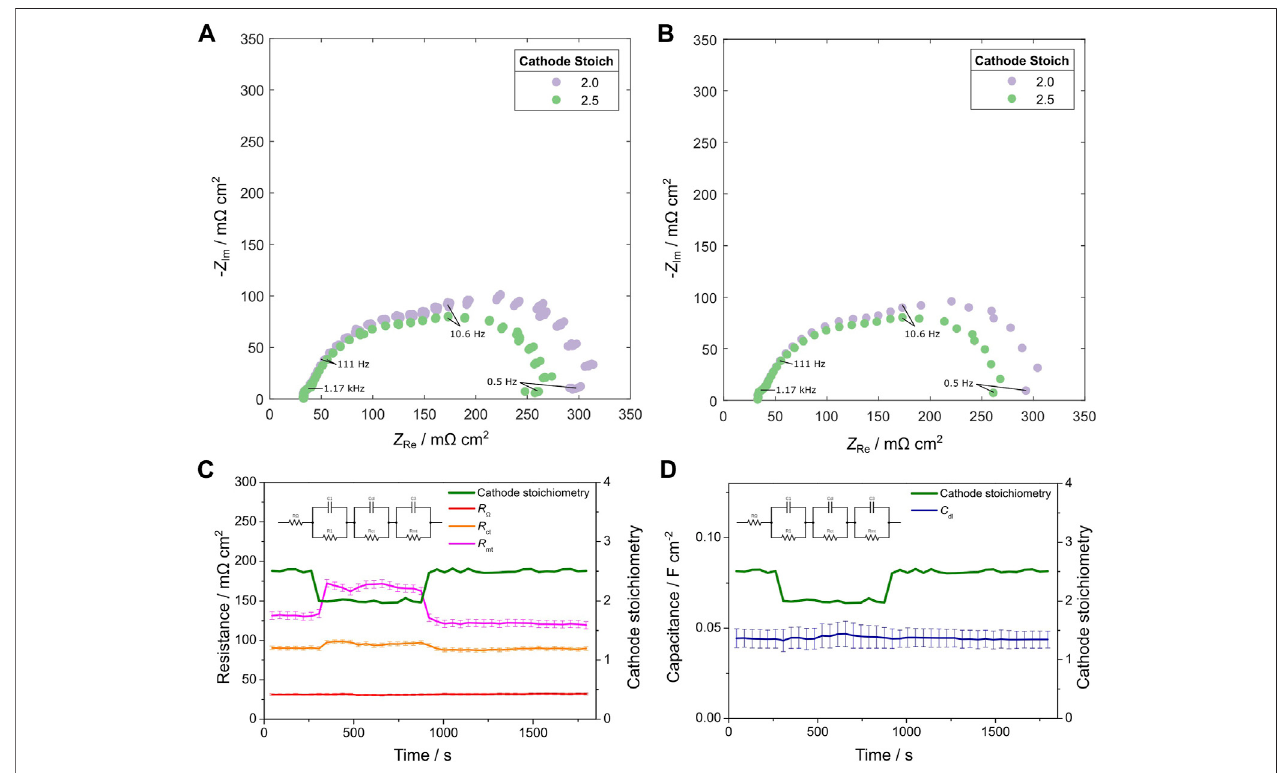
FIGURE5 | EIS spectra and fi tted values from changes incathode stoichiometry; (A) Nyquist plot ofall measurements, (B) Nyquist plot ofselectedmeasurements at the cathode stoichiometry setpoints, (C) fi tted resistance values and cathode stoichiometry as a function of time, and (D) fi tted capacitance value and cathode stoichiometry as a function of time.